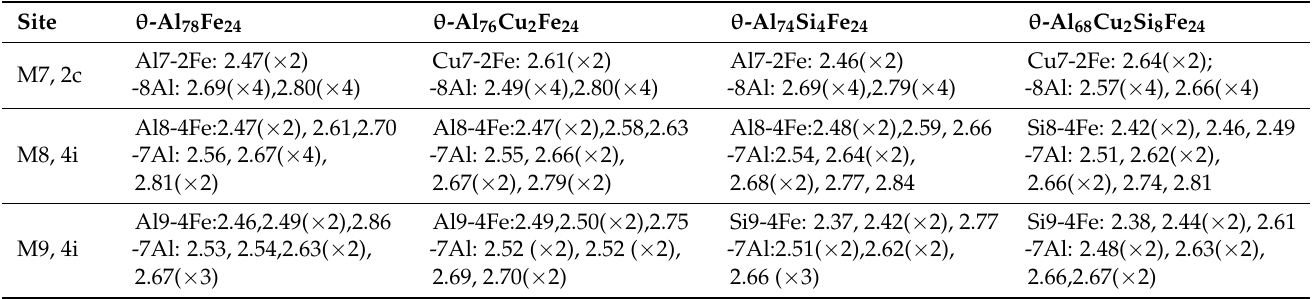
Table 3. Comparison of the local coordination for the selected atoms in the pristine, Cu or/and Si solutioned and Si-Cu co-solutioned θ